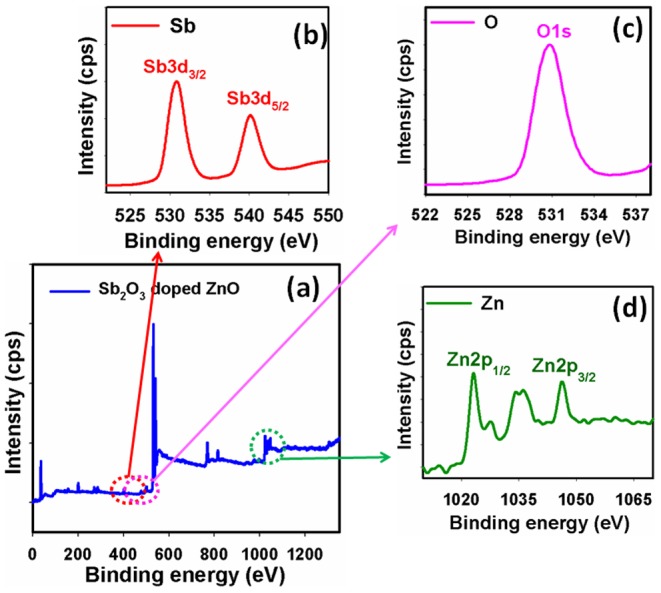
XPS of (a) doped Sb2O3-ZnO MFs, (b) Sb3d level, (c) O1s level, and (d) Zn2p level acquired with MgKα1 radiation.